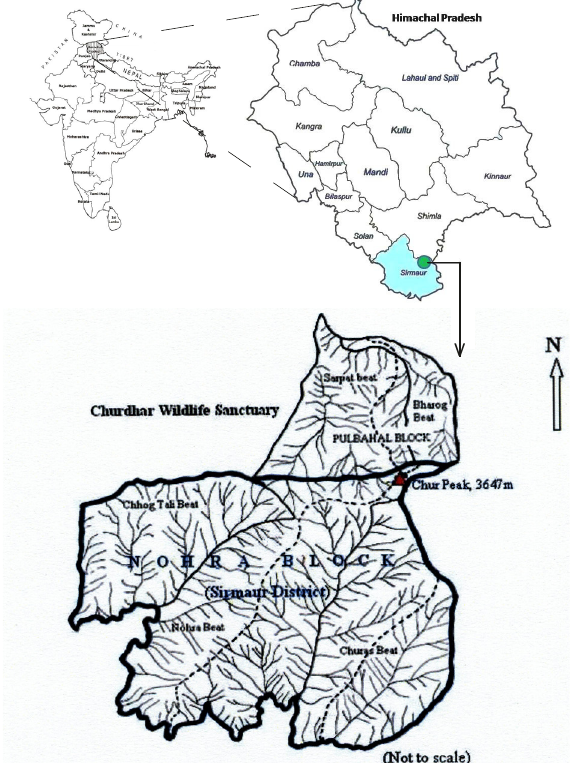
Figure 1. Churdhar Wildlife Sanctuary showing location of Nohra Block, Sirmaur District, Himachal Pradesh